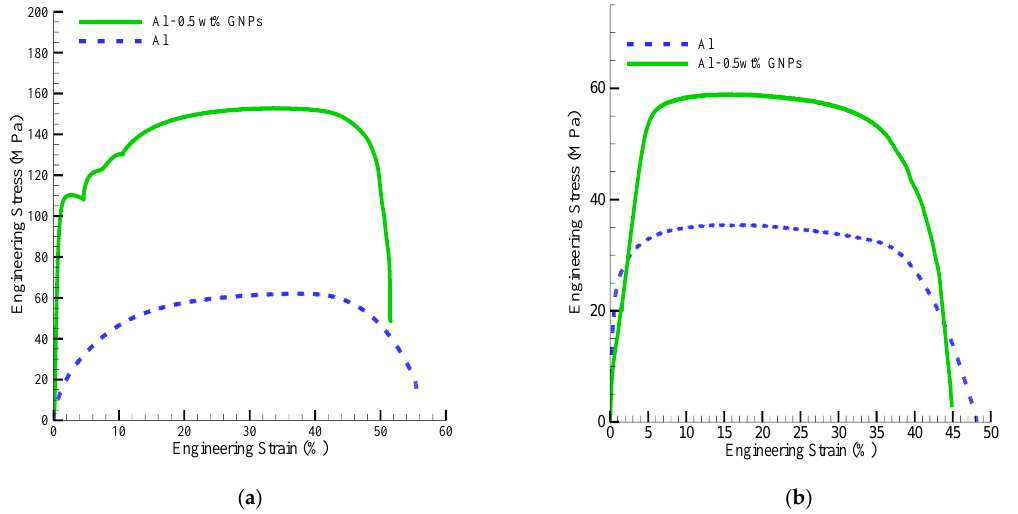
Figure 7. Comparison of tensile properties of Al and Al – 0.5 wt% GNPs at a temperature of ( a ) 20 °C ( b ) 180 °C.